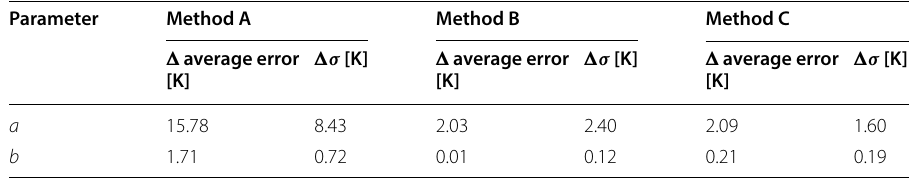
The absolute differences are shown for variations of a and b between 50 % and 150 % of the original values (see Fig.